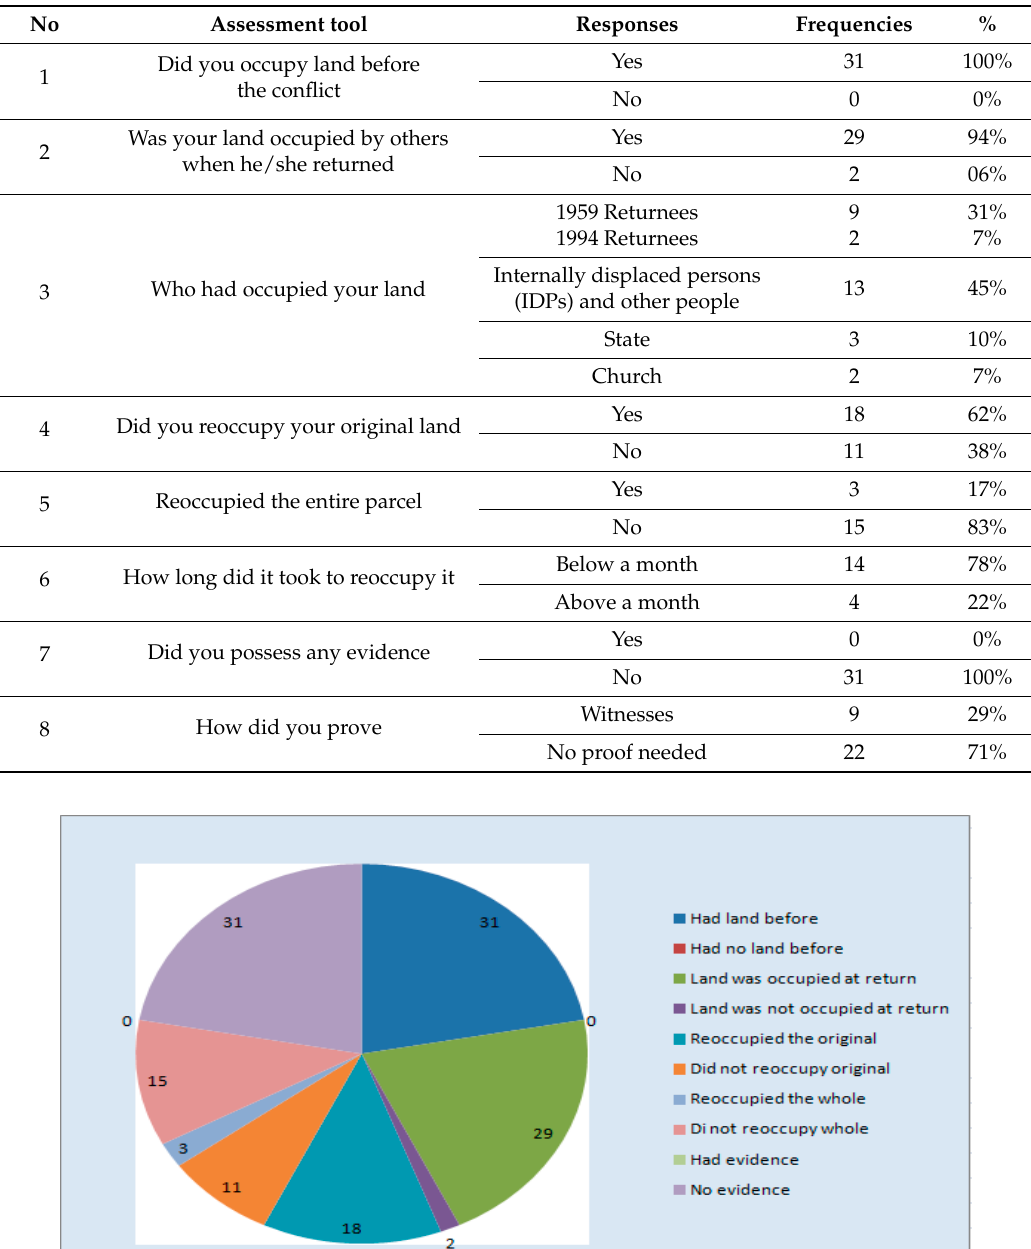
Table 1. Fieldwork results on land owned by displaced persons [3].